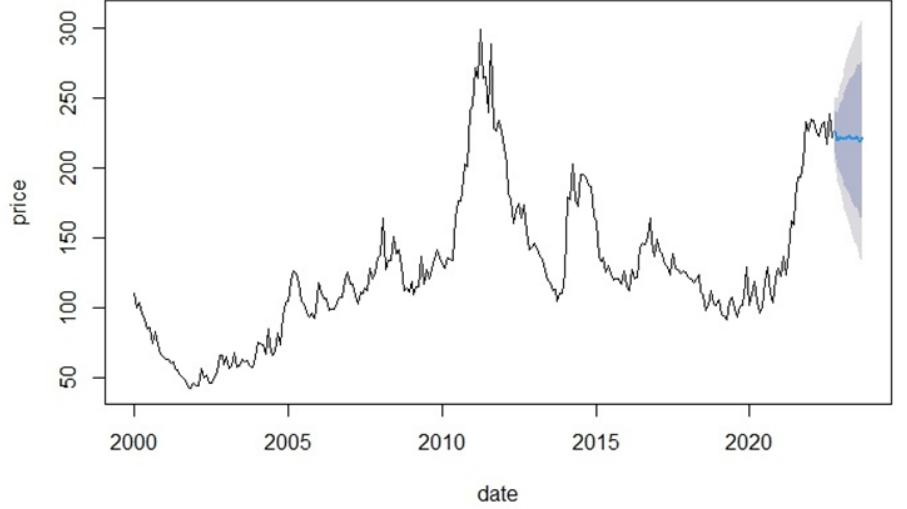
Figure 6. SARIMA(2,1,1)(0,0,1) prediction of coffee price trend on the ICE Futures US commodity exchange. Own processing based on data from Yahoo Finance.